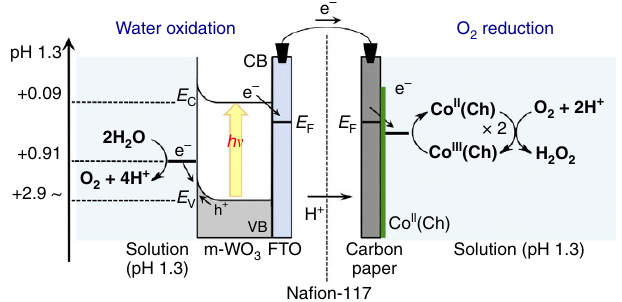
Figure 1 | Overall scheme of photocatalytic production of H 2 O 2 . Photocatalytic production of H 2 O 2 from water and O 2 using m-WO 3 /FTO photoanode and Co II (Ch)/CP cathode in water or seawater under simulated 1 sun (AM 1.5G)